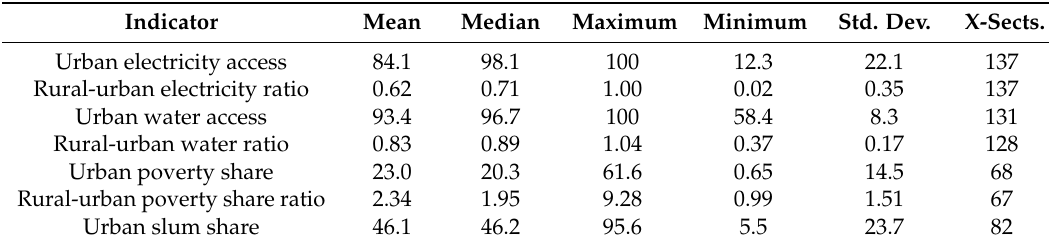
Table 1. Descriptive statistics for urban poverty indicators and rural-urban poverty comparisons. Non-high-income countries. Indicator Mean Median Maximum